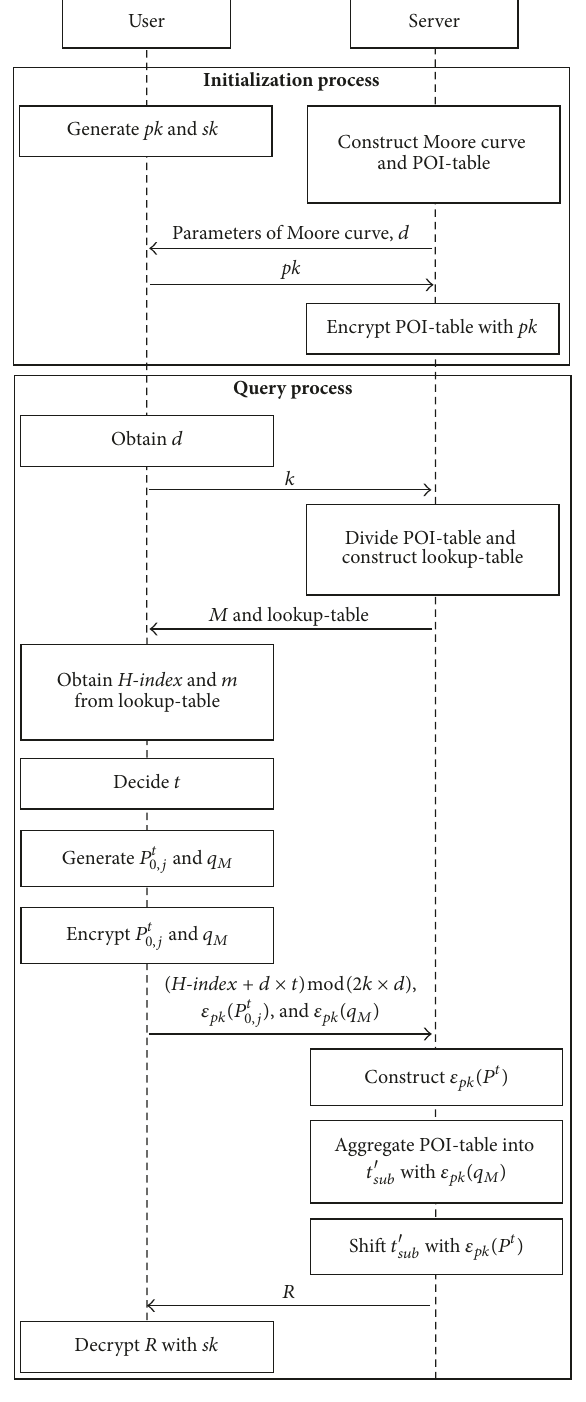
Figure 3: Interaction diagram of